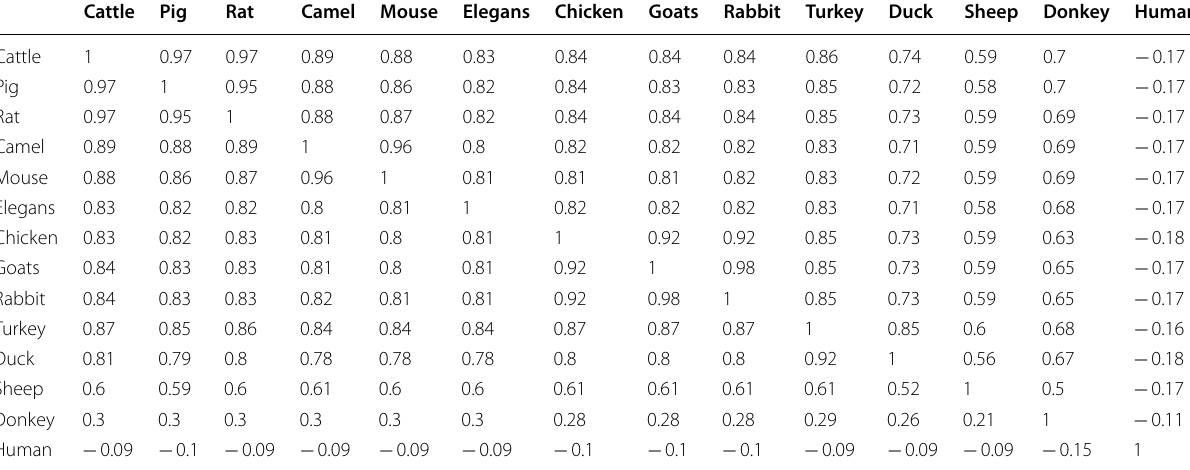
Table 3 Global block substitution matrix (BLOSUM62) similarities among the aligned HSP70 amino acid sequences of the selected animals Cattle Pig